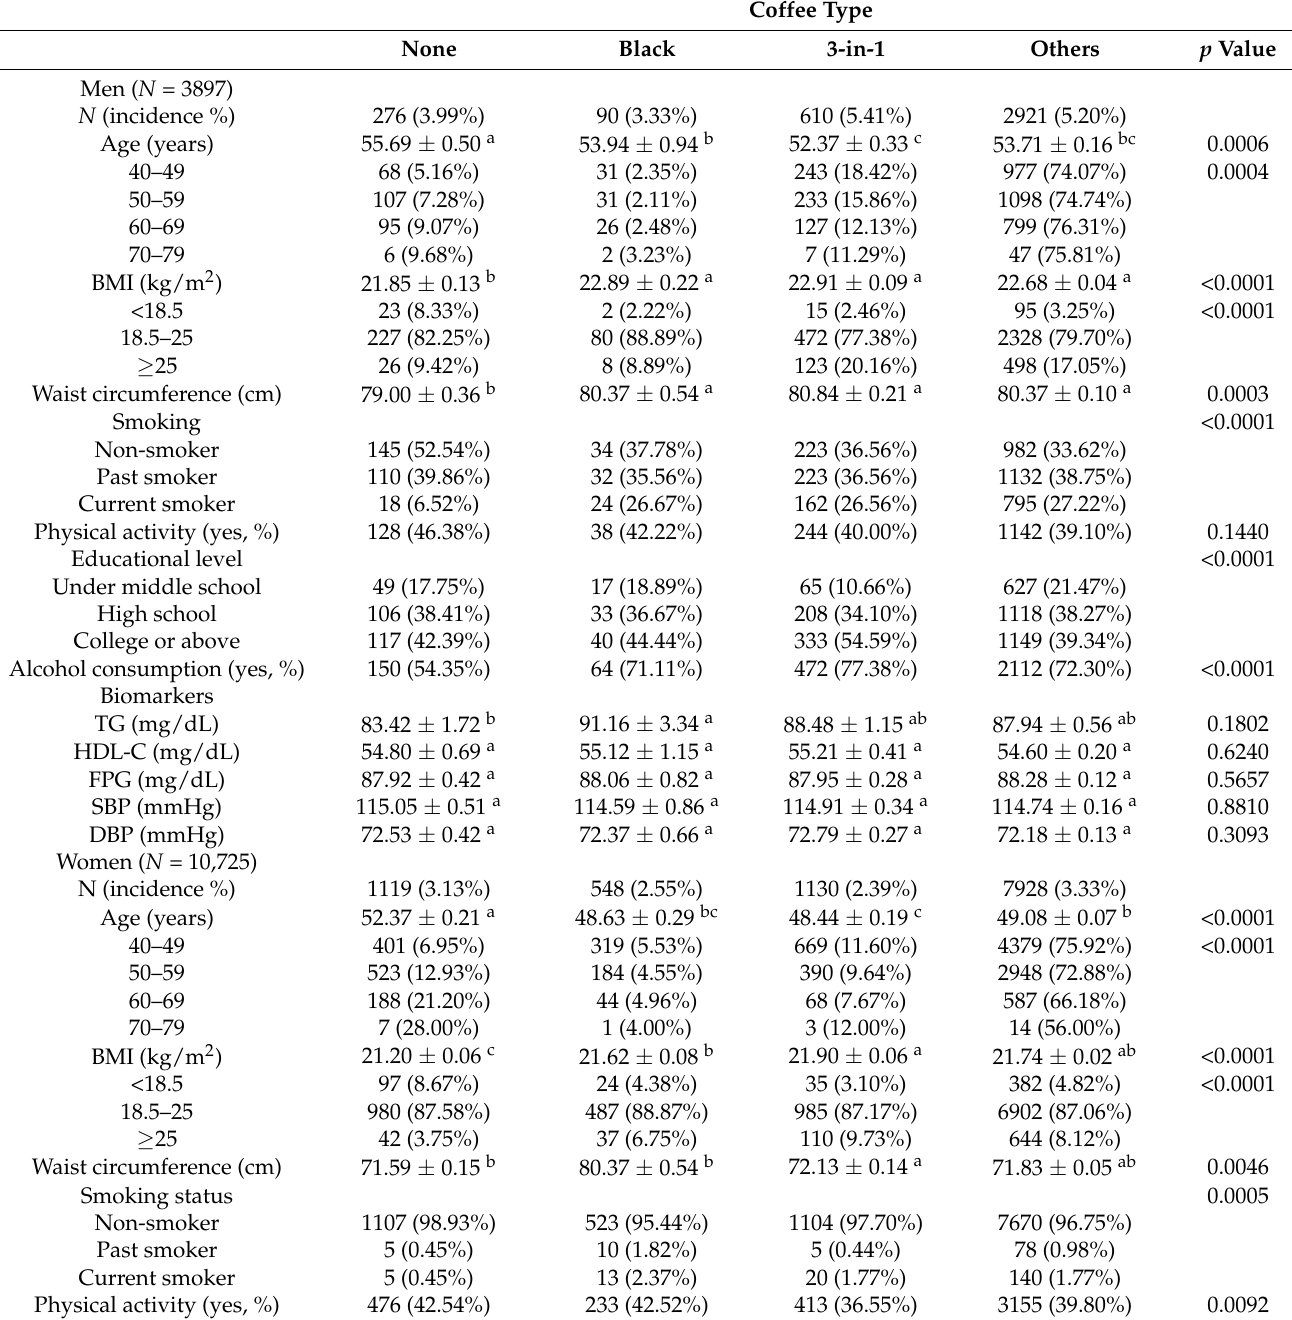
in Table 1. Participant characteristics, based on coffee consumption and coffee intake pattern change, are shown in Supplementary Tables S1 and S2, respectively. Male “3- in-1” and “other” coffee consumers were approximately 91% of male participants; for female participants, this proportion corresponded to approximately 84%. Most participants consumed less than 3 cups of coffee/day (75% in men, and 80% in women). Participants consuming more coffee tended to be younger, smokers, alcohol consumers, more physically active, and with higher BMI values. Moreover, participants who consumed more 3-in-1 coffee tended to be younger, smokers, alcohol consumers, and with higher BMI values. Table 1. Participant general characteristics based on consumed coffee type and sex 1